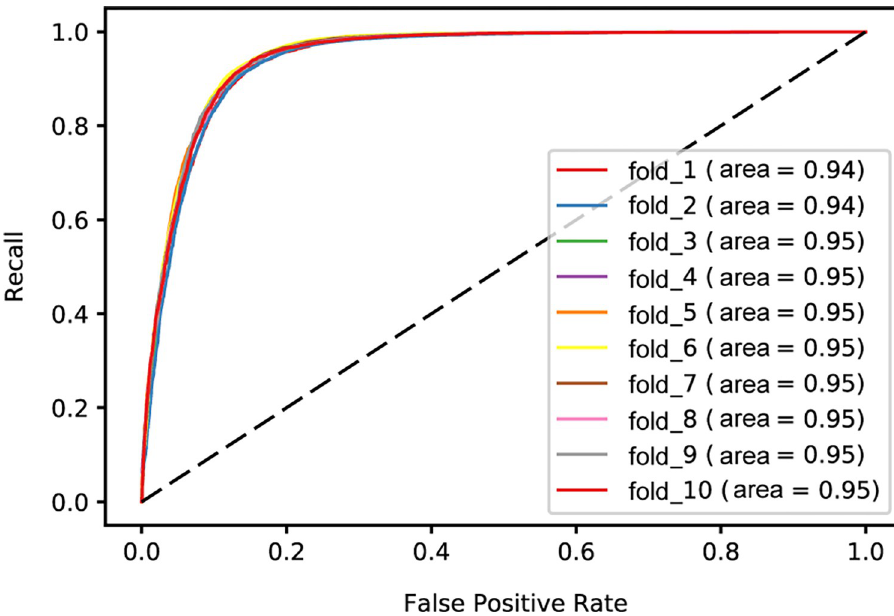
Fig 3. Receiver-operator characteristic curve for the 10-fold cross validated neural network model based on 6-mers and randomly selected 5-kb sequence fragments. Results for each fold are shown.